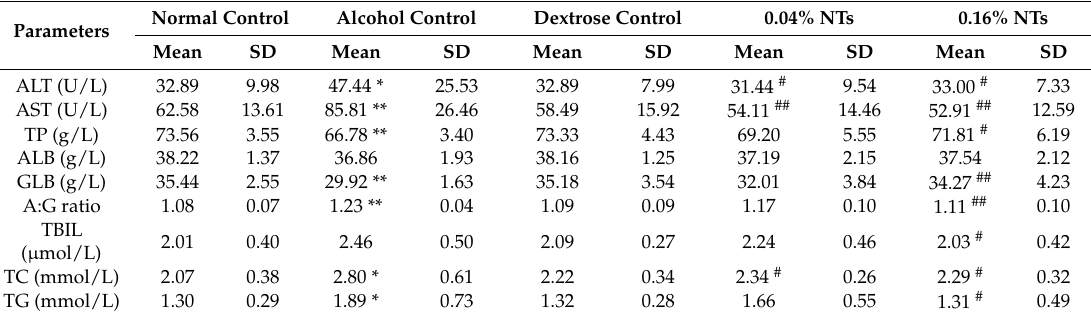
Table 1. Effects of dietary nucleotides (NTs) on aminotransferase, protein, lipid and bilirubin levels in the serum of rats (Mean values and standard deviations, n 10 per group).